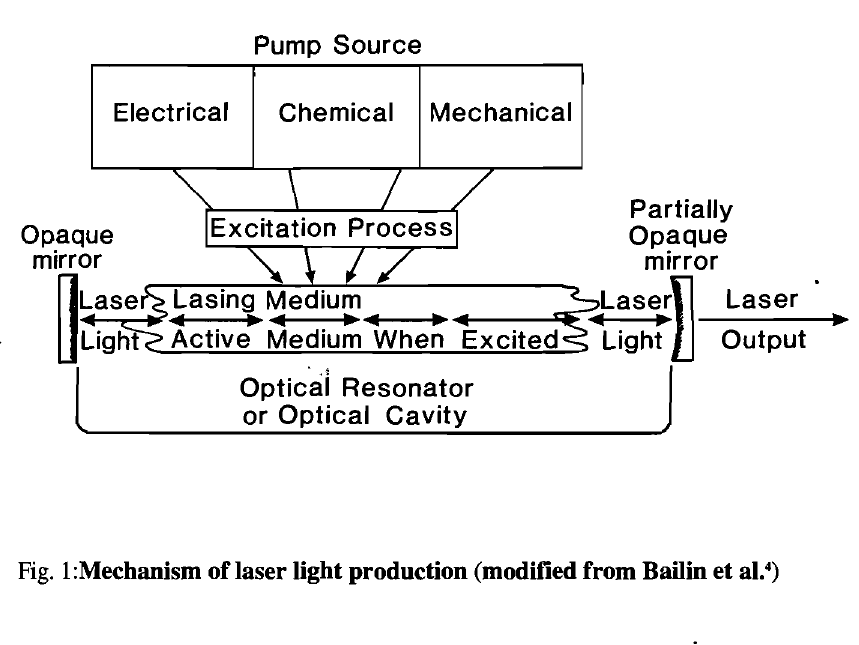
Fig. I:Mechanism of laser light production (modified from Bailin et al. 4 )